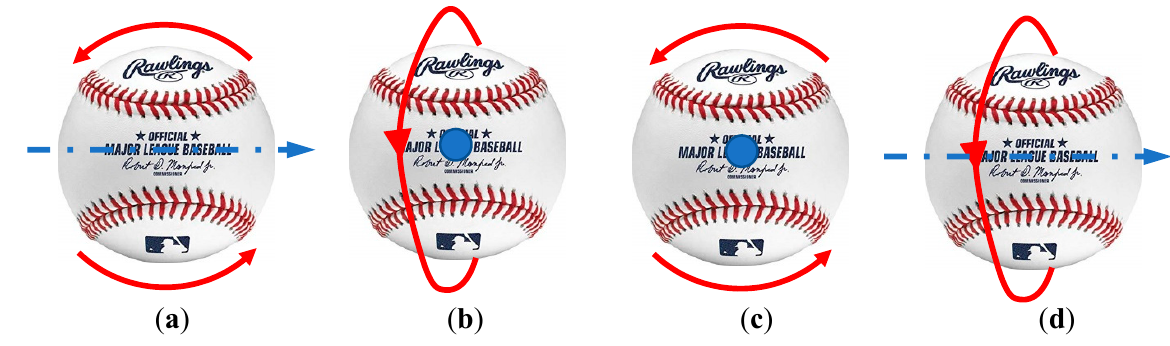
Figure 1. The direction of ball’s linear speed (blue arrow; a dot indicates that the ball goes into the page) and the direction of the spin (red arrow) for each orientation of the spin. ( a ) Four-seam back spin. ( b ) Two-seam back spin. ( c ) Four-seam gyro spin. ( d ) Two-seam gyro spin.